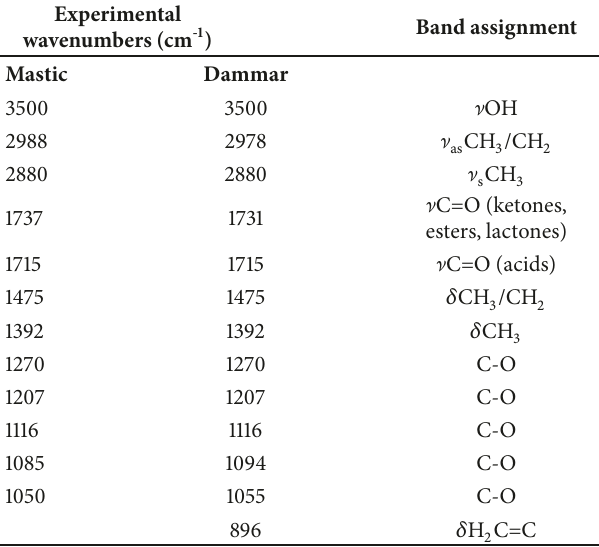
Table 6: Experimental wavenumber values corresponding to the maxima of the mid-IR total reflection mode bands of triterpenoid resins and their tentative